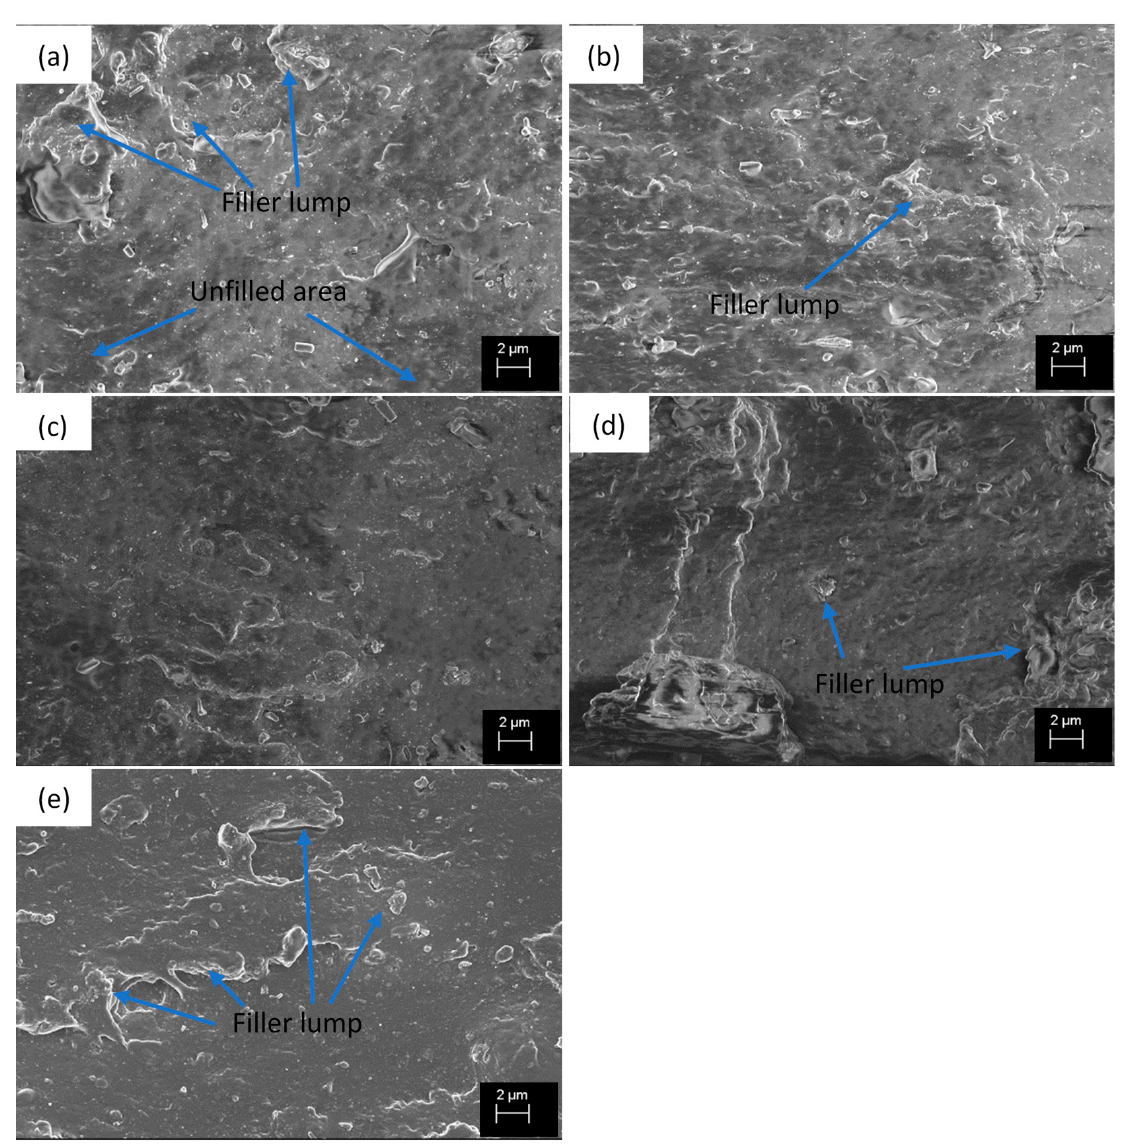
Figure 2. SEM images from the fracture surface (tensile test) of the compounds ( a ) ND0, ( b ) ND0.5, ( c ) ND1, ( d ) ND2.5, ( e ) ND5.